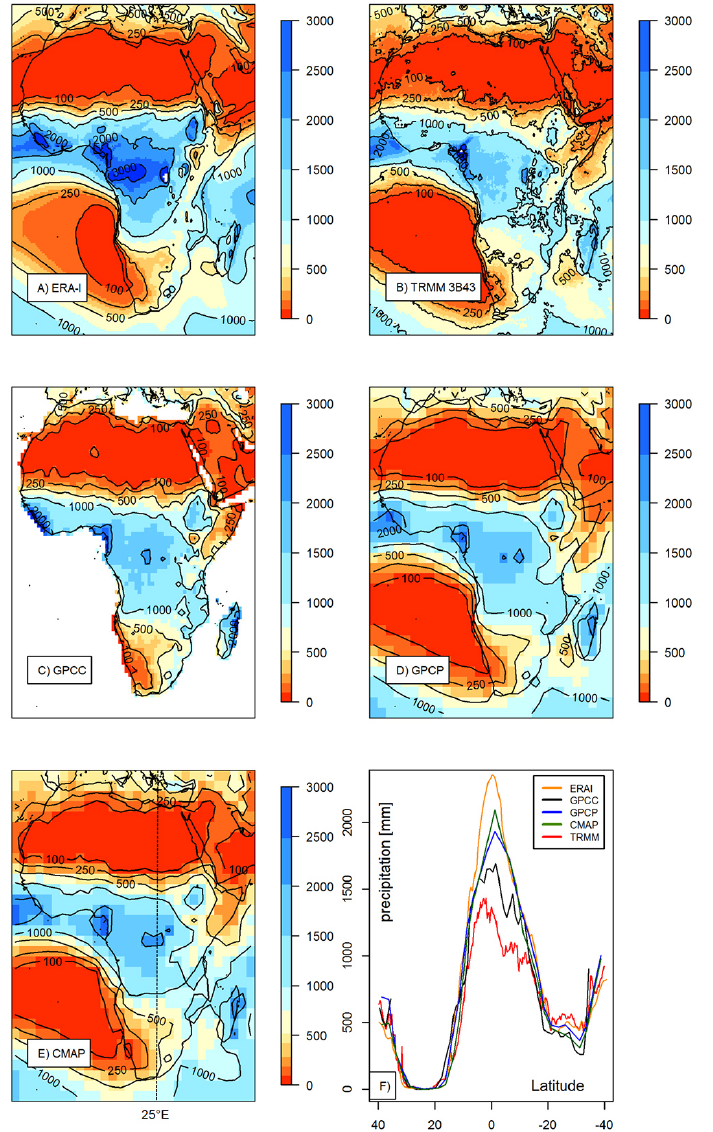
Fig. 2. (A) – (E) Mean annual precipitation (mmyear − 1 ) from different data sets for the common period 1998–2010, (F) longitudinal cross- section at 25 ◦ E of mean annual